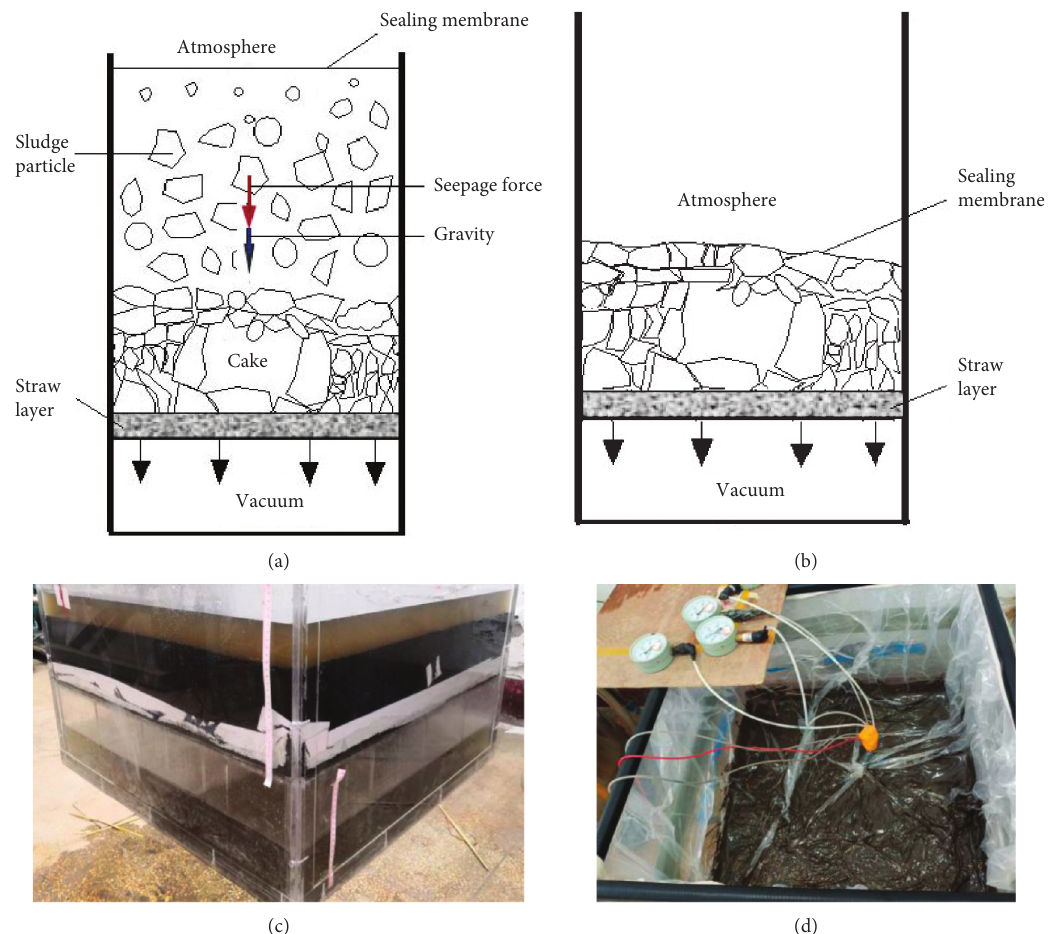
Figure 18: The deposition and consolidation process of sludge particles: (a) and (c), deposition of sludge particles; (b) and (d), gas-water